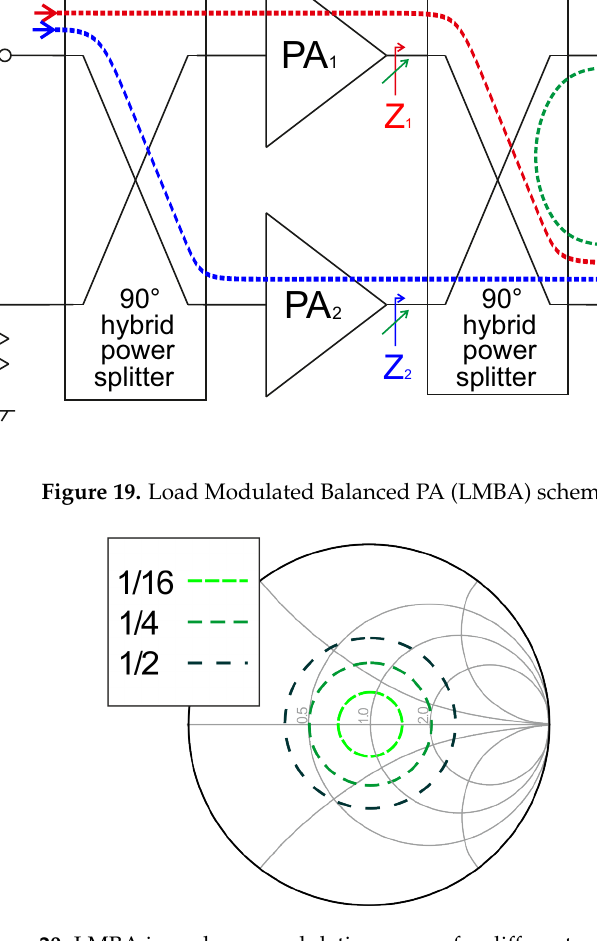
Figure 20. LMBA impedance modulation curves for different values of α